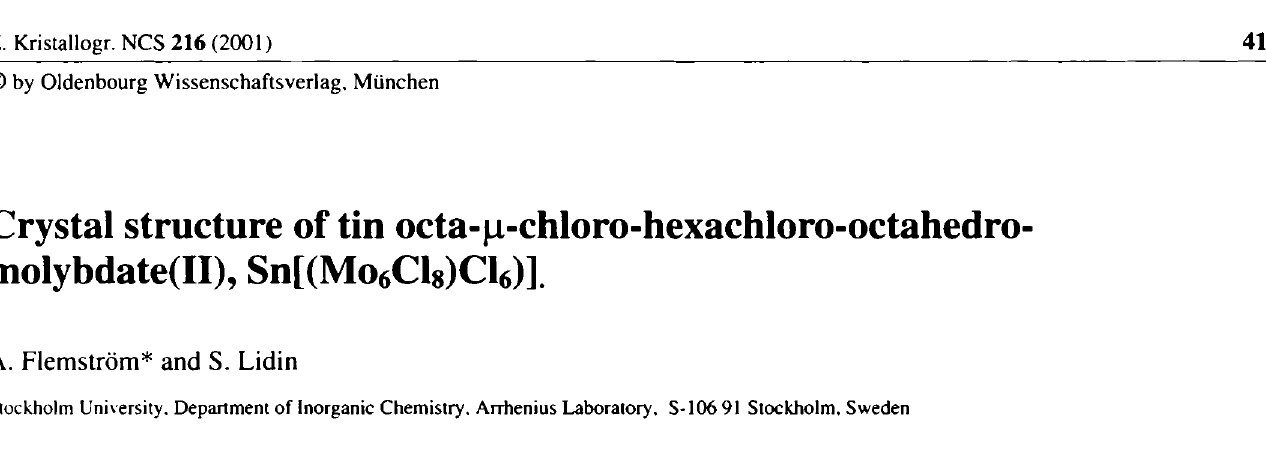
Table 1. Data collection and handling.